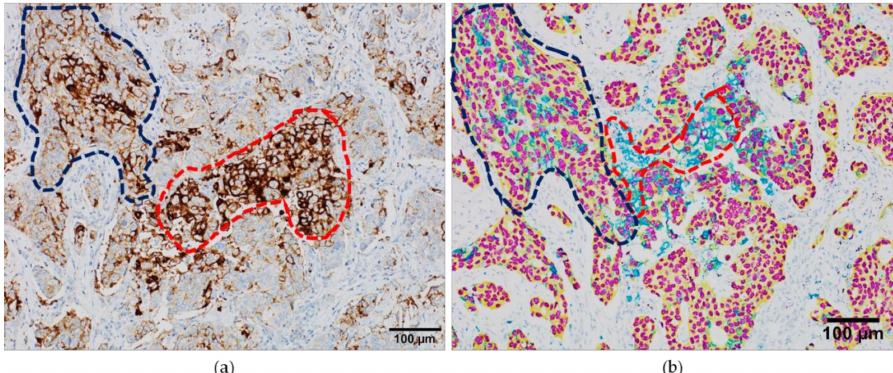
Figure 3. Interpretation of the programmed death-ligand 1 (PD-L1) staining in serial whole-tissue formalin-fixed paraffin embedded samples from a lung adenocarcinoma case. ( a ) PD-L1 expression revealed by conventional immunoperoxidase staining; ( b ) PD-L1 expression revealed by chromogenic multiplexed immunohistochemistry, with the anti-TTF1 antibody colored in purple, anti-AE1/AE3 in yellow and anti-PD-L1 SP263 in teal. Blue dotted line: tumor area; red dotted line, immune